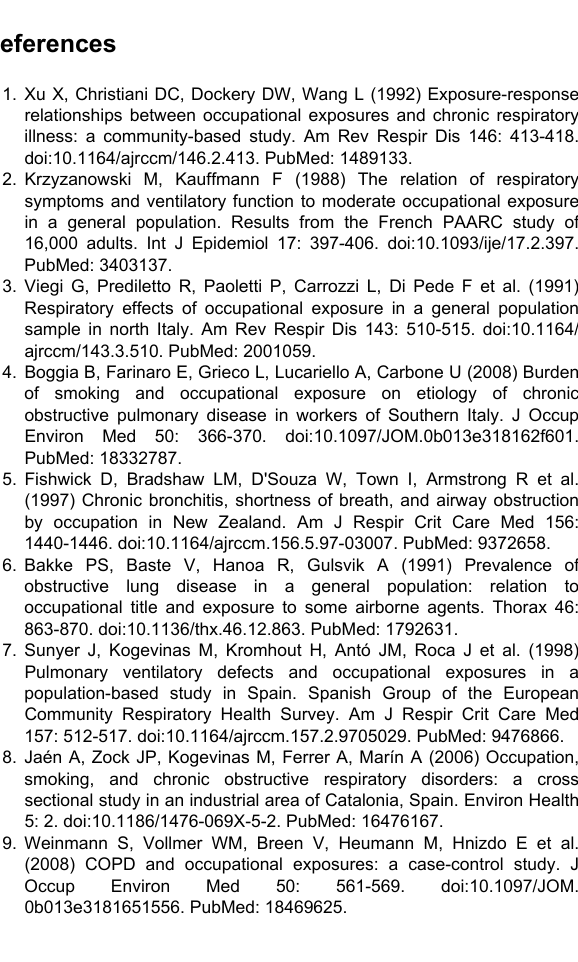
Figure S1, Funnelplot for Figure 2 Mean difference (MD) of FEV1 [liter] between study participants exposed to bg dust at the workplace and no/low exposed participants. Figure S2, Funnelplot for Figure 3 Mean difference (MD) of FEV1 in % predicted between study participants exposed to bg dust at the workplace and no/low exposed participants. Figure S3, Funnelplot for Figure 4 Standardized mean difference of the ratio FEV1/FVC between study participants exposed to bg dust at the work place and low/no exposed participants. Figure S4, Funnelplot for Figure 5 Decrease of FEV1 (ml) in relation to the cumulative exposure to bg dust at the workplace